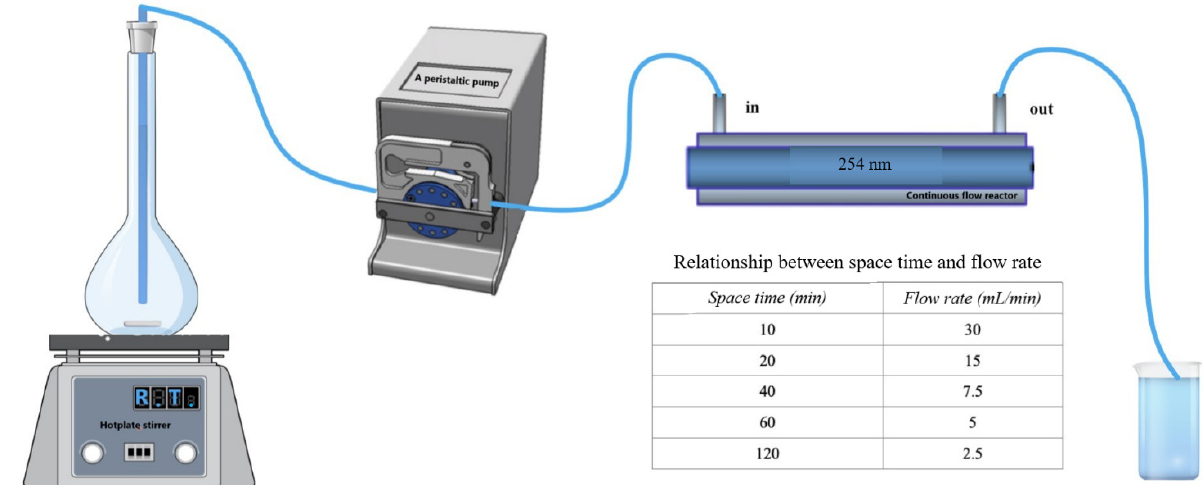
Figure 1. Experimental setup for the continuous flow photodegradation of